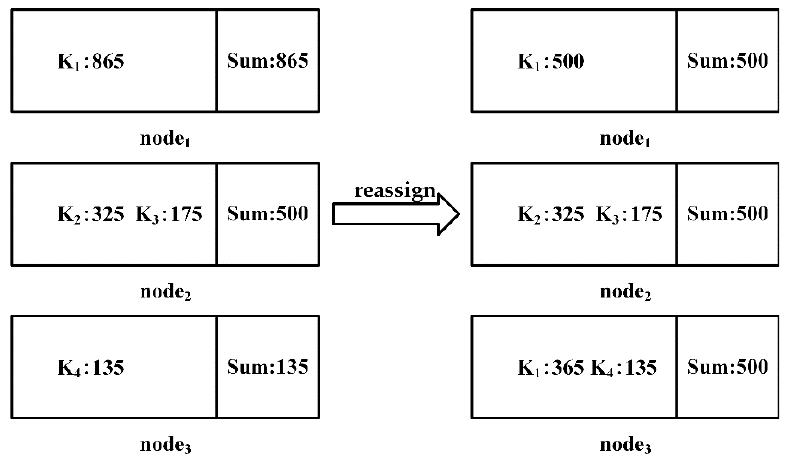
Figure 5. Task assignment to achieve load